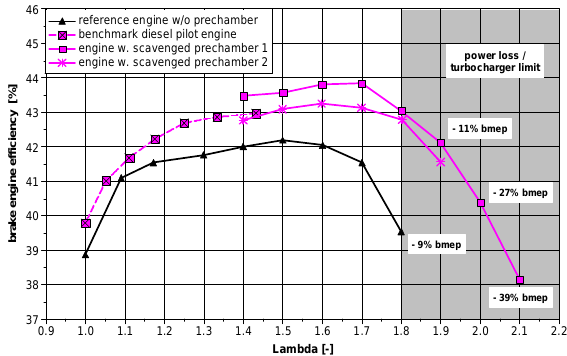
Fig. 8. Brake engine efficiencies for the operating point 2 (2000 rpm/ 220 Nm/bmep 14.0 bar)